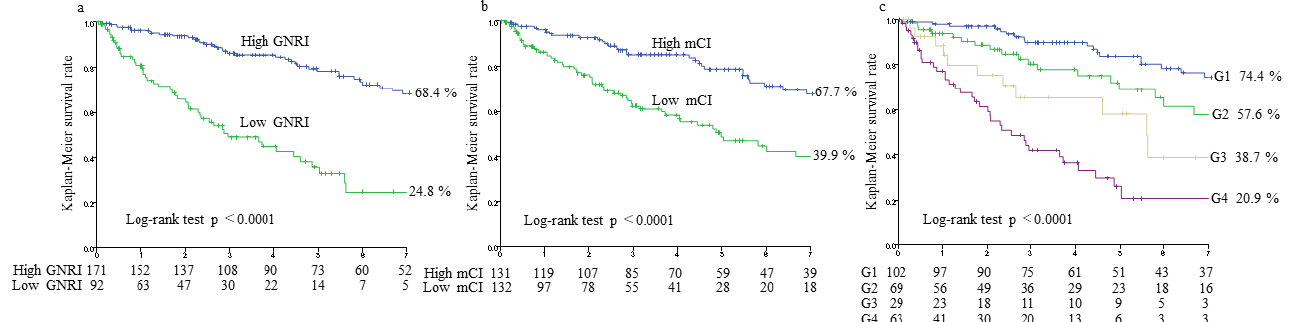
Figure 2. Kaplan–Meier survival curves for all-cause mortality. All-cause mortality rates for two groups of geriatric nutritional risk index (GNRI) < 91.2 vs. GNRI ≥ 91.2 ( a ), two groups of modified creatinine index (mCI) <20.16 mg/kg/day vs. mCI ≥ 20.16 mg/kg/day ( b ), and four groups of combined GNRI and mCI ( c ). G1 (group 1), GNRI ≥ 91.2 and mCI ≥ 20.16 mg/kg/day; G2 (group 2), GNRI